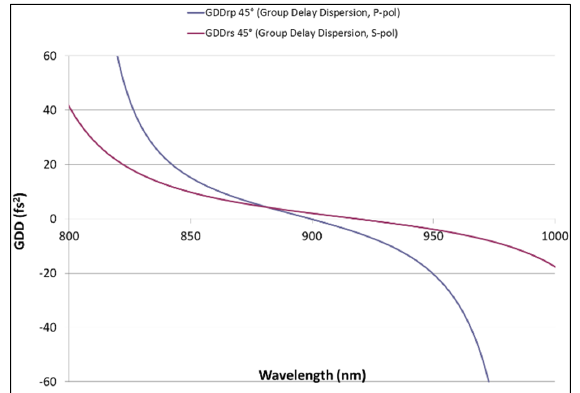
Figure 6. GDD on reflection as a function of wavelength for 45° AOI, Spol and Ppol, for the BBHR coating design, shown on an expanded GDD scale.